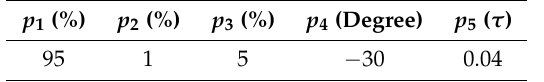
Table 3. Sensor- and scene-independent parameter settings for the endmember computation algorithm over ROIs in